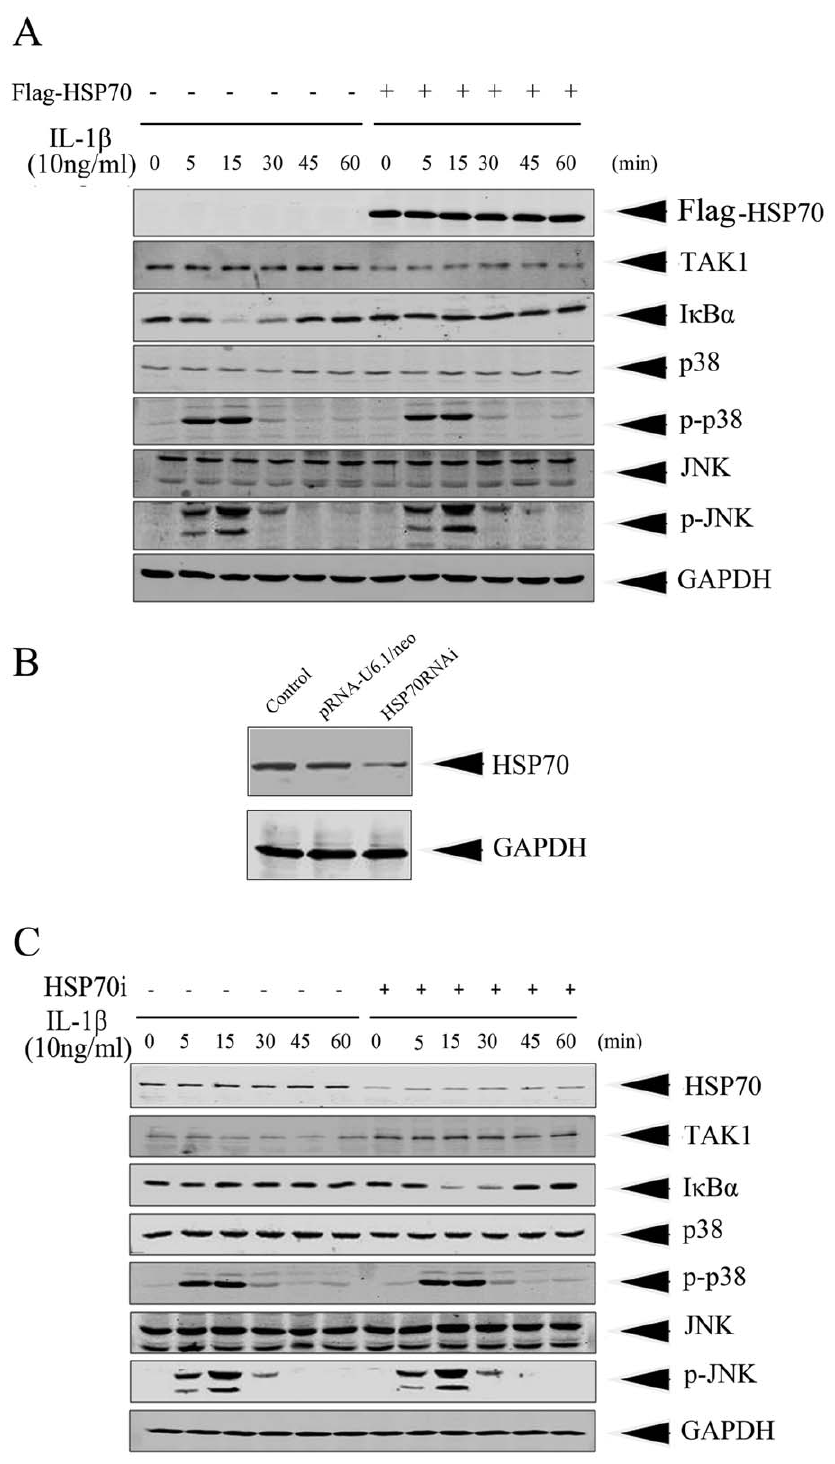
Figure 4. Inducible HSP70 modulated IL-1 b -induced activation of TAK1-NF- k B cascades, but not of TAK1-MAPKs. (A) HeLa cells were transfected with pcDNA3.0 ( 2 ) or pcDNA3.0-Flag-HSP70 ( + ) for 48 h and then stimulated with IL-1 b (10 ng/ml) for indicated times. Cell lysates were prepared and subjected to immunoblotting with anti-I k B a , anti-phospho-p38 (p-p38, Thr180/Tyr182), and anti-phospho-JNK (p-JNK, Thr183/Tyr185) antibodies, respectively, to reveal the activation of NF- k B and MAPKs. Total cellular TAK1, p38, and JNK protein levels in cell lysates were also determined by immunoblotting with specific antibody respectively. (B) HeLa cells were either non-transfected (control) or transfected with pRNA- U6.1/neo vector or pRNA-U6.1/neo-HSP70i construct. After 48 h transfection, cells were exposed to IL-1 b (10 ng/ml) for 12 h and cell lysates were subjected to immunoblotting with anti-HSP70 antibody to determine the efficiency of RNAi, GAPDH was used as an internal control. (C) HeLa cells were transfected with either pRNA-U6.1/neo vector or pRNA-U6.1/neo-HSP70i construct. After 48 h transfection, cells were stimulated with IL-1 b (10 ng/ml) for indicated times. immunoblotting with anti-I k B a , anti-phospho-p38 (p-p38, Thr180/Tyr182), and anti-phospho-JNK (p-JNK, Thr183/